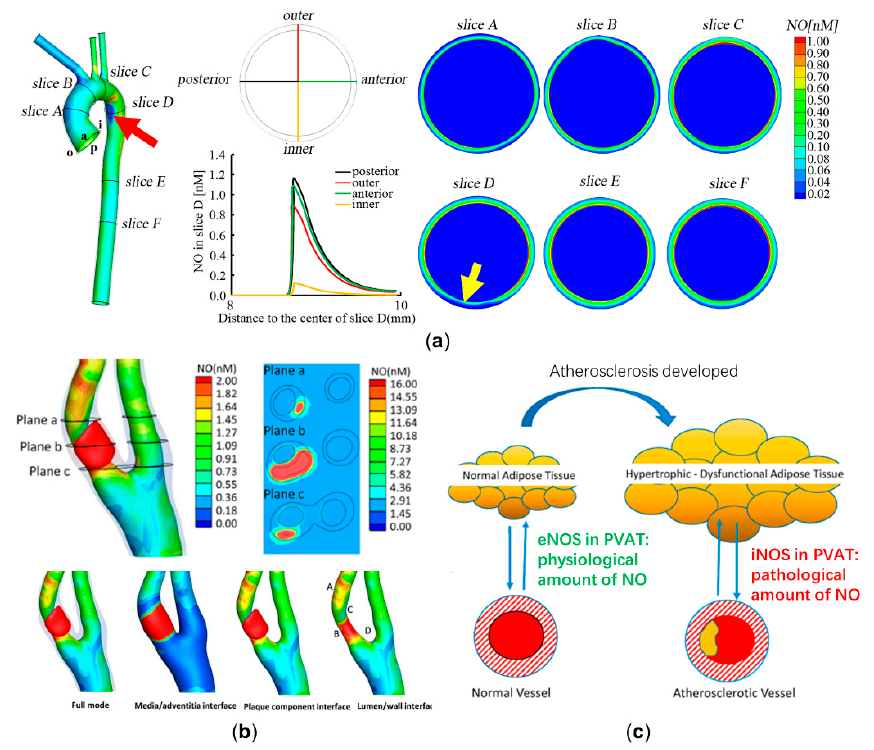
Figure 2. Computational modeling of nitric oxide (NO) delivery to assess atherosclerotic development. ( a ) NO distributions of six representative slices in the physiological aorta. NO distribution at slice D is the most uneven (a relative low NO concentration at the position indicated by a yellow arrow), corresponding to an atherosclerosis-prone site (the inner wall of the distal end of aortic arch has relative low NO concentration, which is marked by a red arrow) [31] . ( b ) A high NO concentration in the lipid pool is illustrated. NO distribution around atherosclerotic plaque is quite uneven, with the high levels at point A and point B and the low levels at point C and point D. ( c ) The effects of NO delivery by physiological and atherosclerotic perivascular adipose tissue (PVAT). Panel ( b ) is reproduced with permission from Reference [30], Elsevier. Panel ( c ) is adapted with permission from Reference [50] , Elsevier.